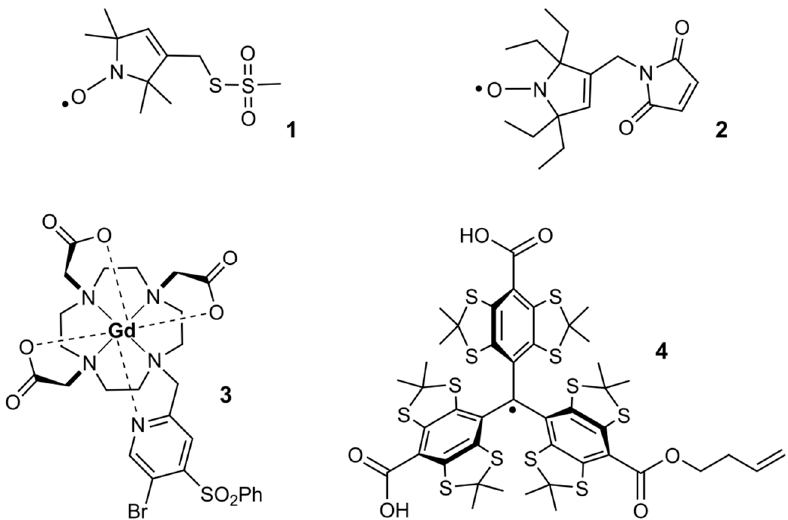
Figure 1. The molecular structures of selected spin labels: MTSSL 1 , M-TETPO 2 , BrPSPy-DO3A-Gd(III) 3 , TSL-BUTENE 4 .